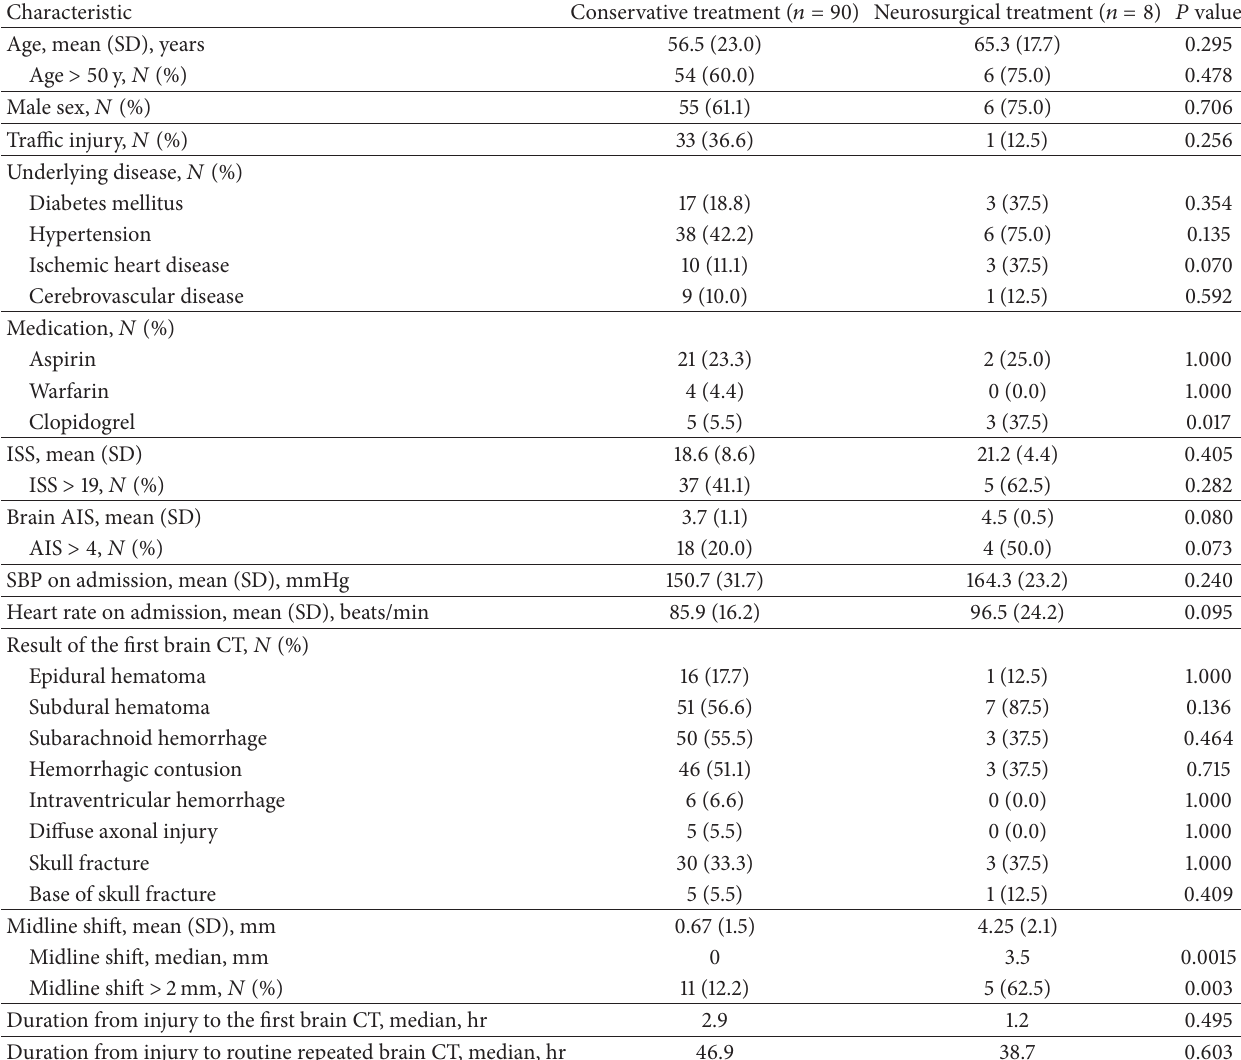
Table 2: Clinical characteristics between conservative treatment group and neurosurgical treatment group after routine repeated brain CT in mild TBI (GCS 13–15).